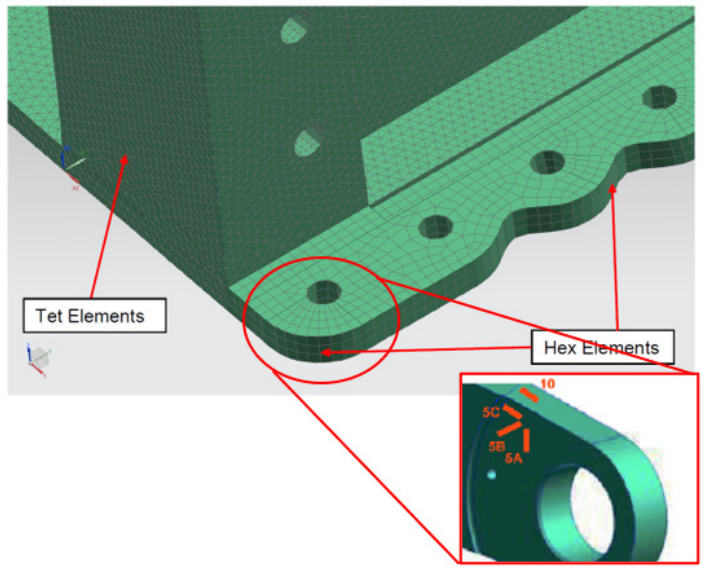
Figure 10. N.X. mesh of the wing root structure portion and strain gauge position.